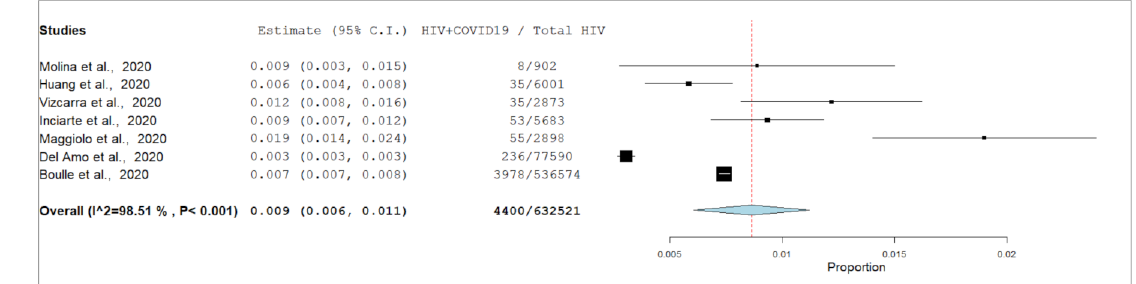
Figure 2. Pooled incidence proportion of COVID-19 among PLHIV based on data accumulated from cohort